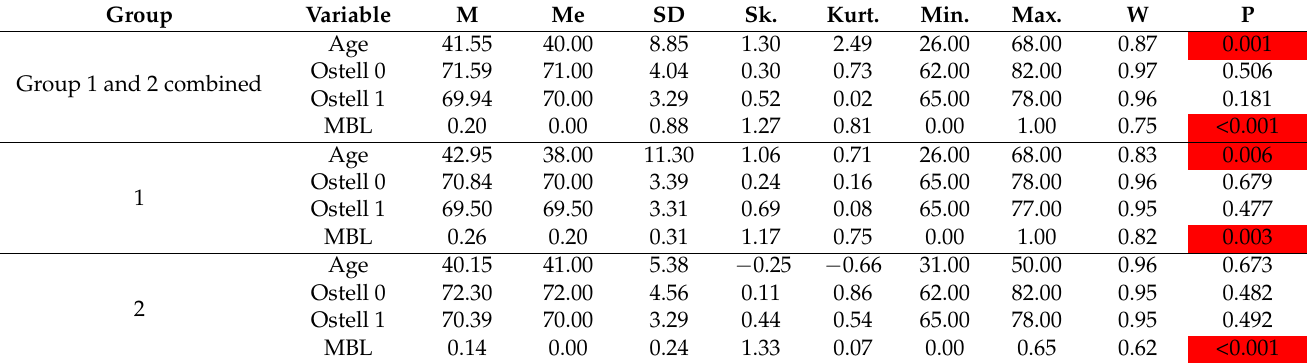
Table 1. Descriptive statistics and the normality test to determine distribution for selected variables. Group Variable M Me SD Sk. Group 1 and 2 combined